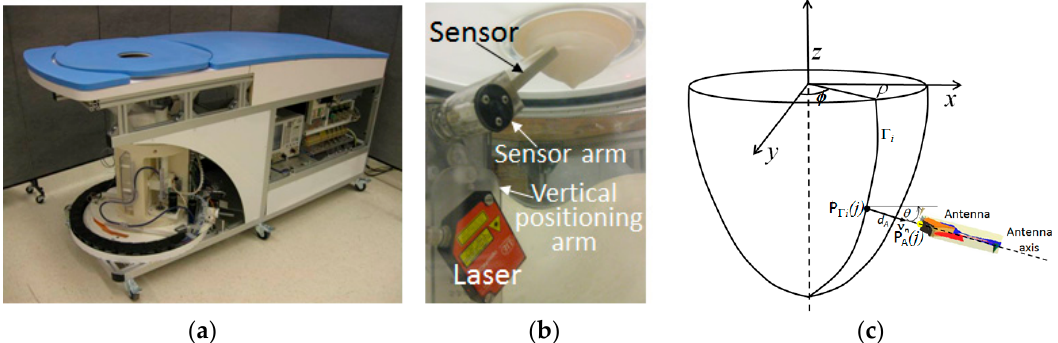
Figure 1. ( a ) Prototype with capability to position sensor with 4 degrees of freedom. ( b ) Laser and microwave sensor connected to vertical positioning arm. ( c ) Robotic arm is incrementally rotated around breast by angle ϕ and moves laser in vertical direction to estimate breast profile Γ i . Sensor arm controls angle of inclination θ and distance d A of aperture P A from point on breast surface P Γ i .